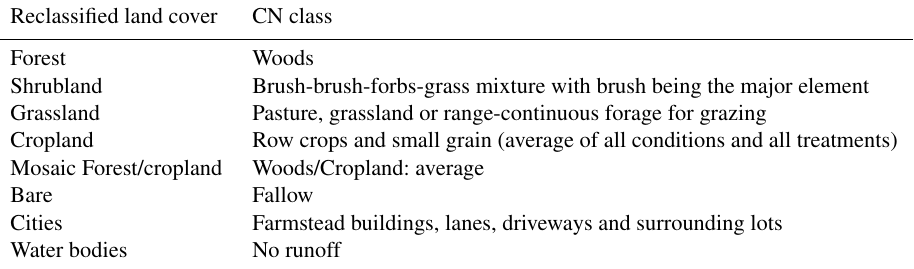
Table A2. Reclassification to CN classes (based on reclassification of Maetens, 2013).